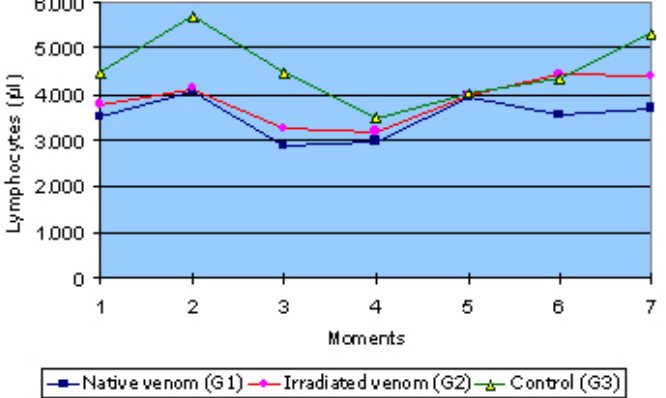
Figure 6: Mean values of total eosinophils count (/µl) in ovine groups inoculated with natural (G1) and 60 Co- irradiated (G2) C.d.t. venom, and control group (G3), at different moments.